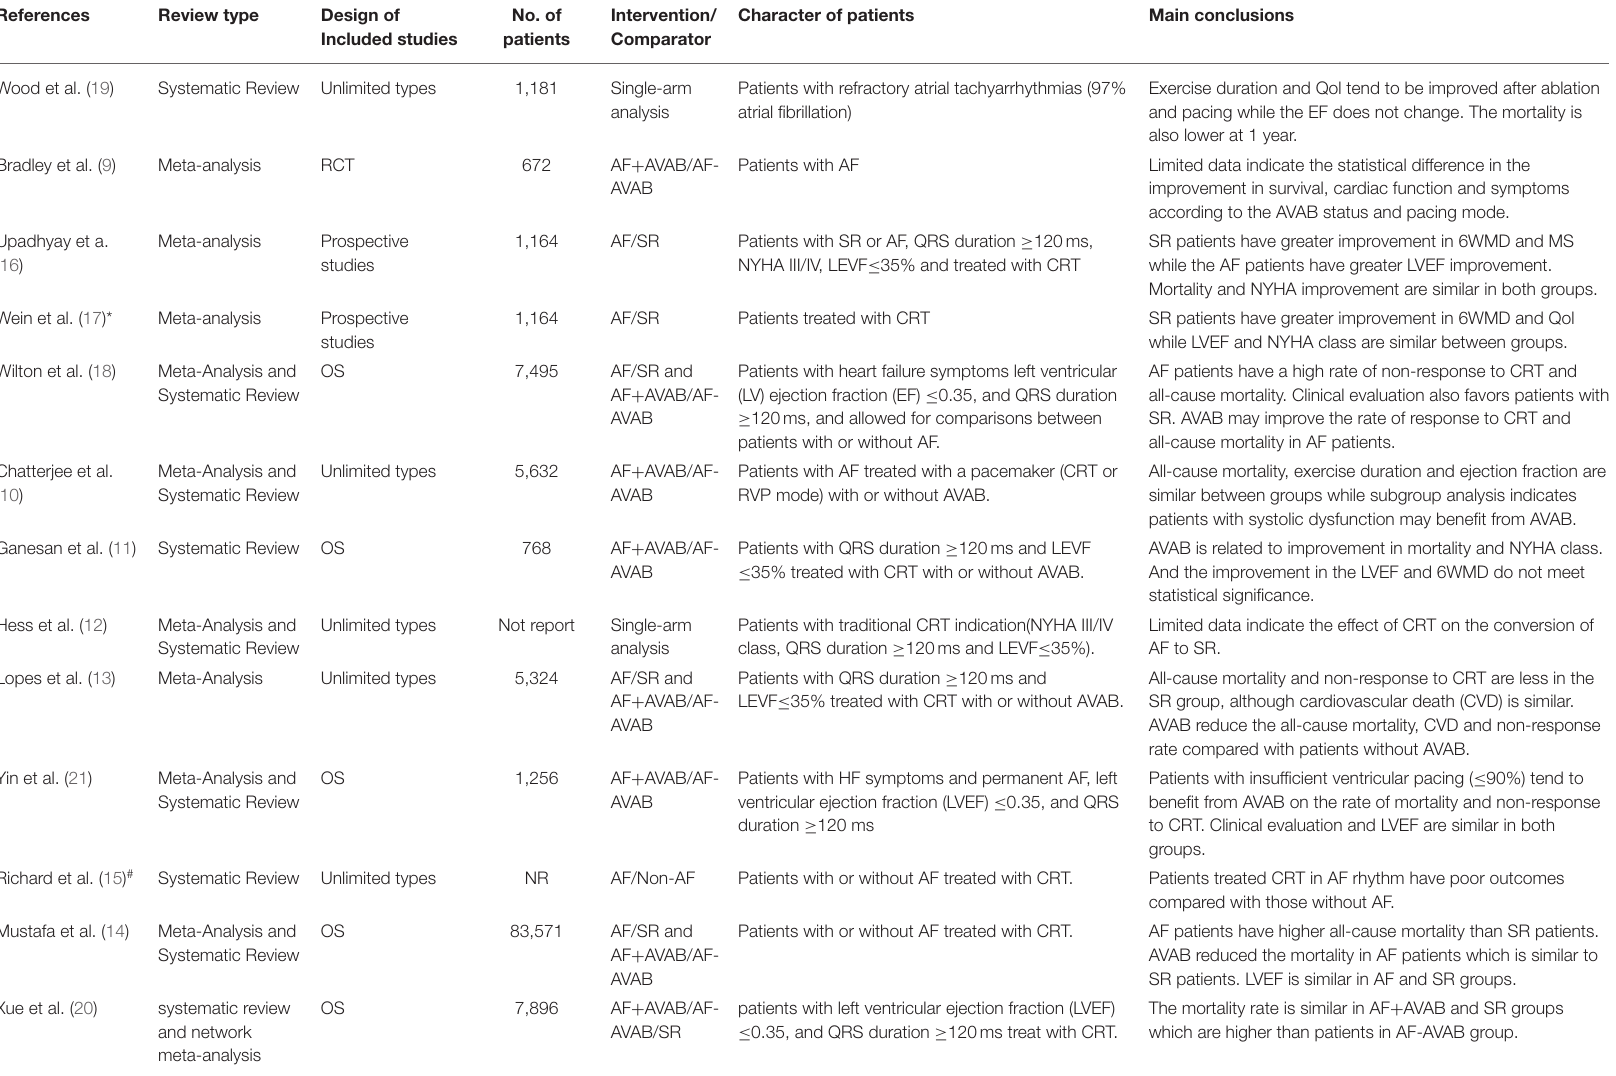
TABLE 1 | The main character of the included systematic reviews and